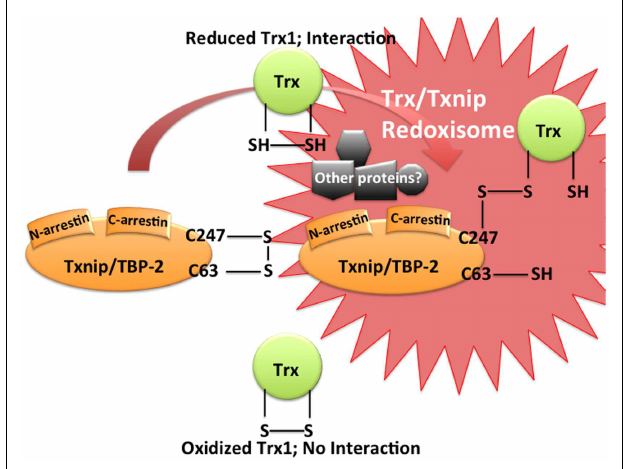
FIGURE 1 |Trx/Txnip signaling complex as redoxisome .Txnip contains an intramolecular disulfide band between Cys-63 and -247 that allows efficient interaction withTrx.Txnip forms disulfide bond with reducedTRX by disulfide exchange, making a stableTrx mixed disulfide.